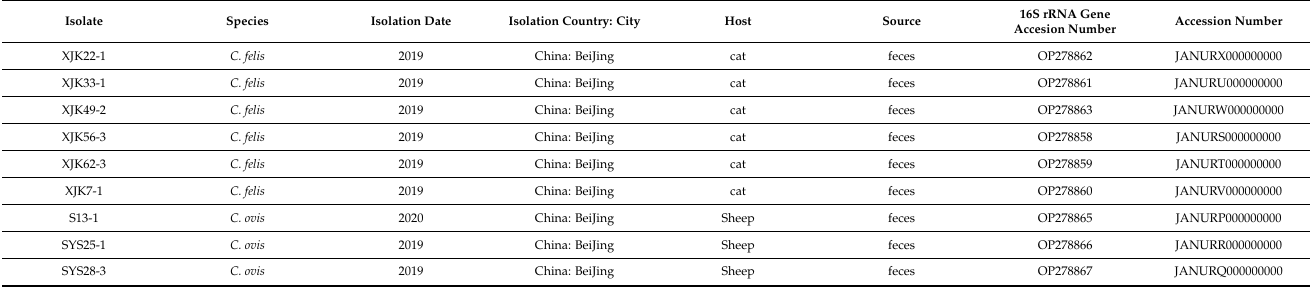
Table 2. Background of strains Campylobacter felis sp. nov. and Campylobacter ovis sp.